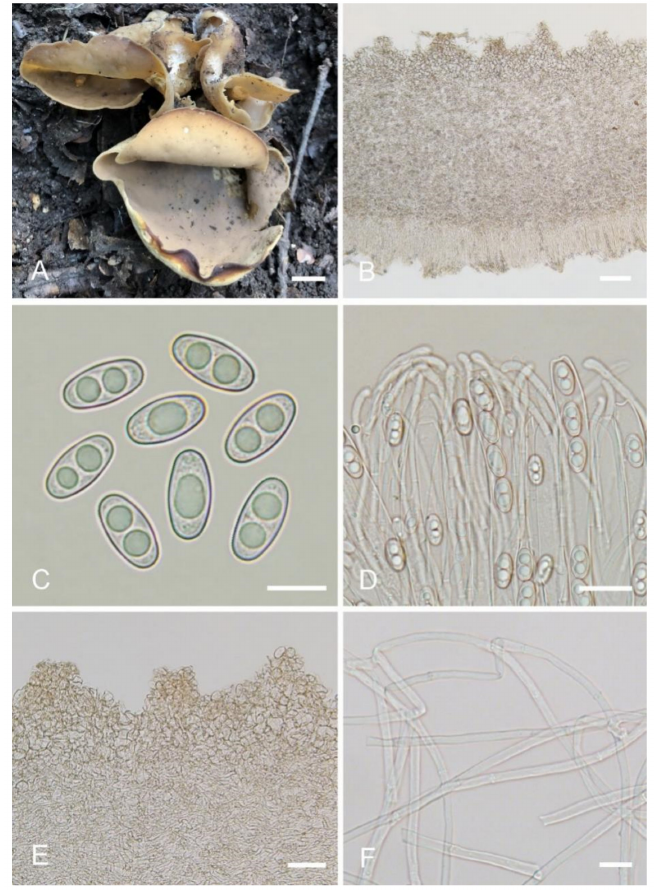
Figure 3. Otidea aspera (HSA 278) ( A ) apothecia, ( B ) anatomy of apothecium, ( C ) ascospores, ( D ) asci and paraphyses, ( E ) ectal excipulum in water, and ( F ) basal mycelium. Scale bars: ( A ) = 1 cm, ( B ) = 100 µ m, ( C ) = 10 µ m; ( D ) = 20 µ m; ( E ) = 50 µ m; ( F ) = 10 µ m. MycoBank: